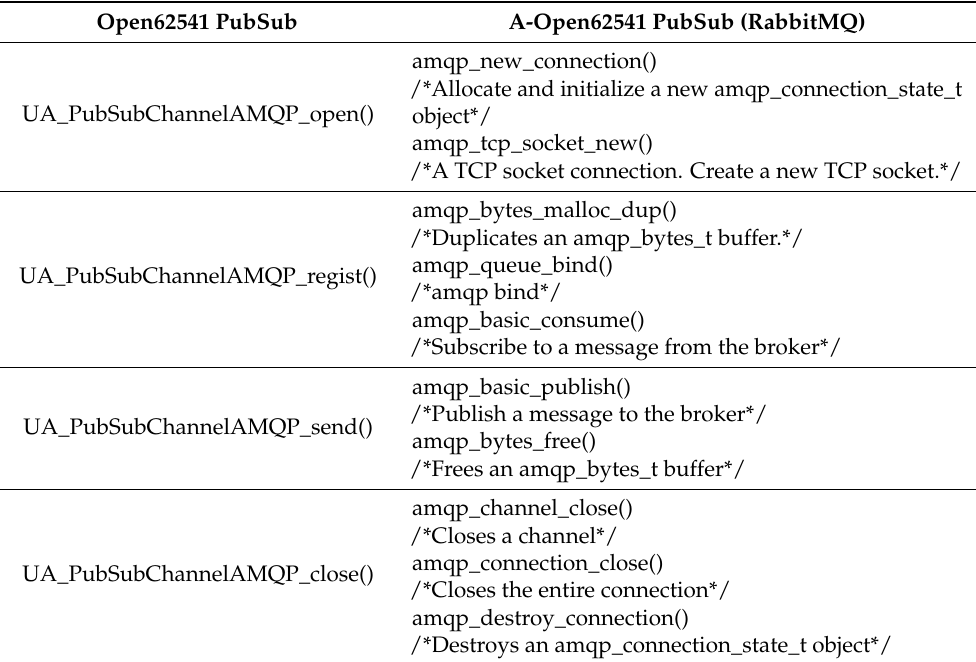
Table 5. A-Open62541 PubSub RabbitMQ